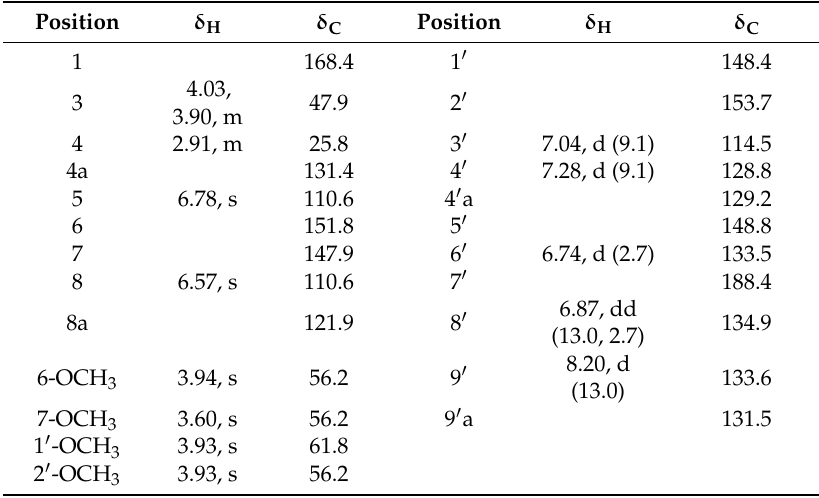
Table 1. 1 H and 13 C NMR data for mahimbrine A (400/100 MHz, in CDCl 3